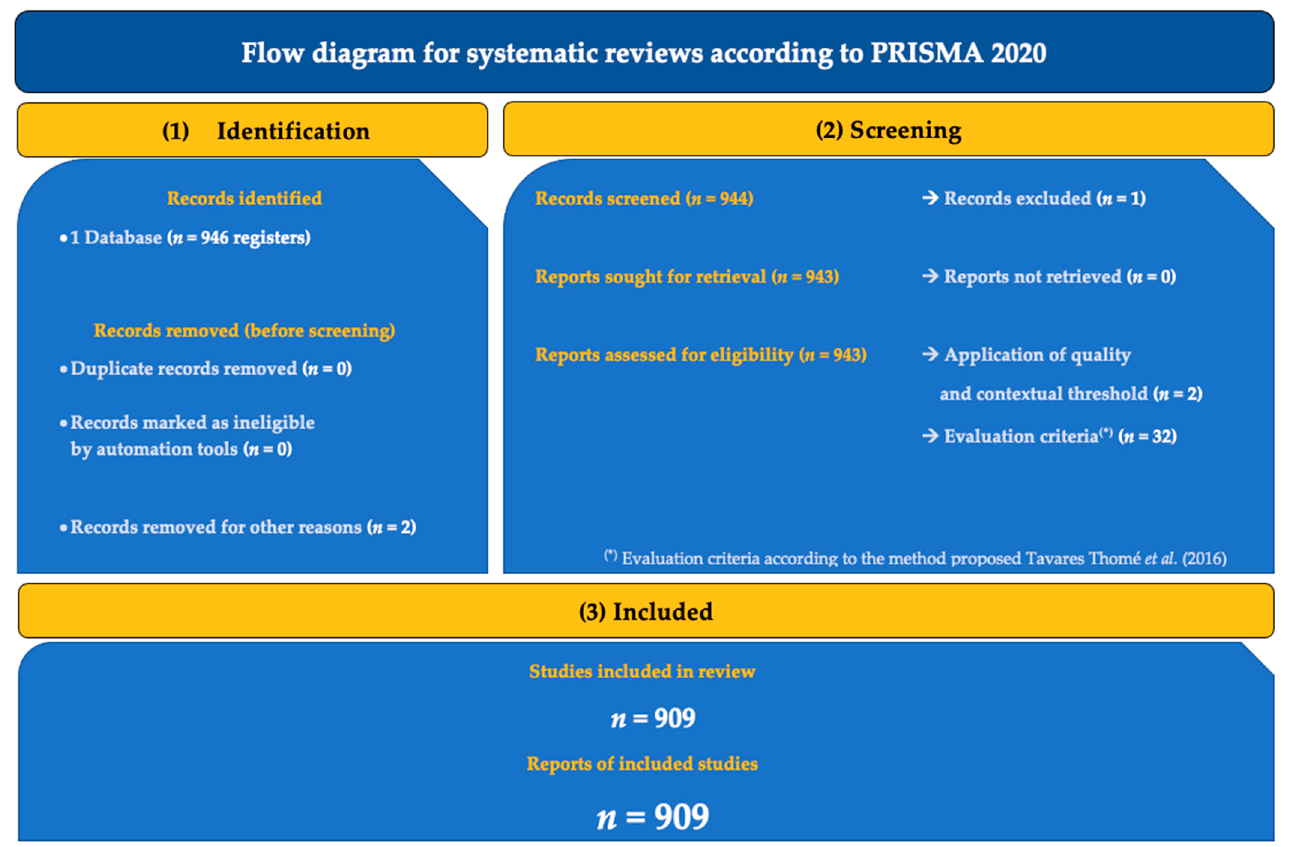
Figure 2. PRISMA 2020 flow diagram. Own elaboration according to Page et al. (2021) [51], Tavares Thomé et al. (2016) [58].